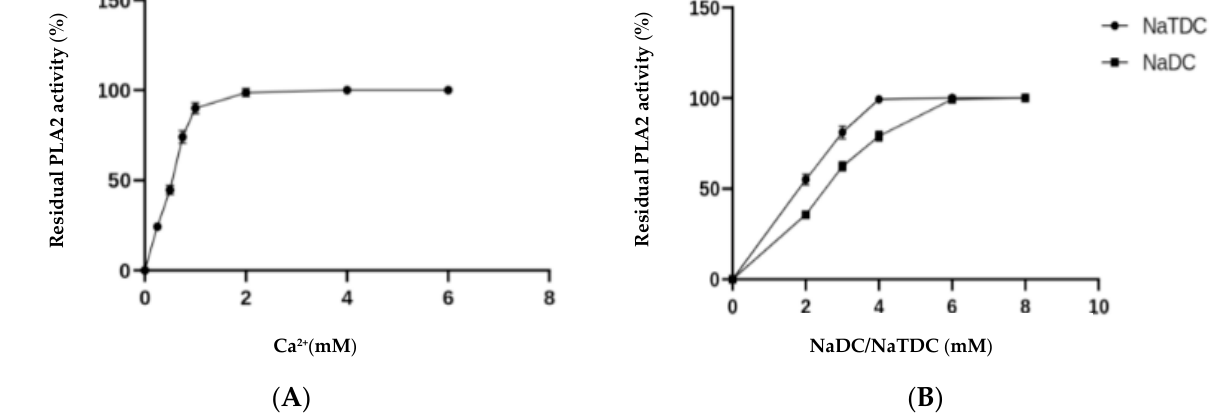
Figure 3. Effect of calcium ions ( A ), and surfactant ( B ), on DrPLA 2 -V activity . The incubation time with the appropriate agent was for a period of 60 min and the remaining phospholipase activity was evaluated at the optimal conditions.